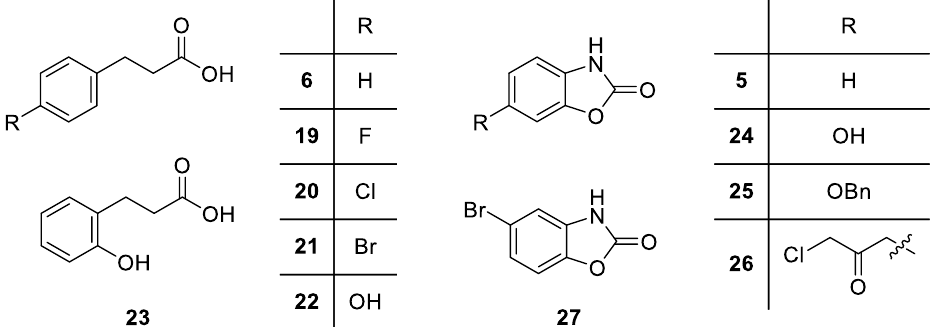
Figure 2. Chemical structures of derivatives of hydrocinnamic acid ( 6 ): 3-(4-fluorophenyl)propionic acid ( 19 ), 3-(4-chlorophenyl)propionic acid ( 20 ), 3-(4-bromophenyl)propionic acid ( 21 ), 3-(4- hydroxyphenyl)propionic acid ( 22 ), 3-(2-hydroxyphenyl)propionic acid ( 23 ), and derivatives of 2-benzoxazolinone ( 5 ): 6-hydroxy-2(3 H )-benzoxazolinone ( 24 ), 6-benzyloxy-2-benzoxazolinone ( 25 ), 6-chloroacetyl-2-benzoxazolinone ( 26 ), 5-bromo-2-benzoxazolinone ( 27 ).